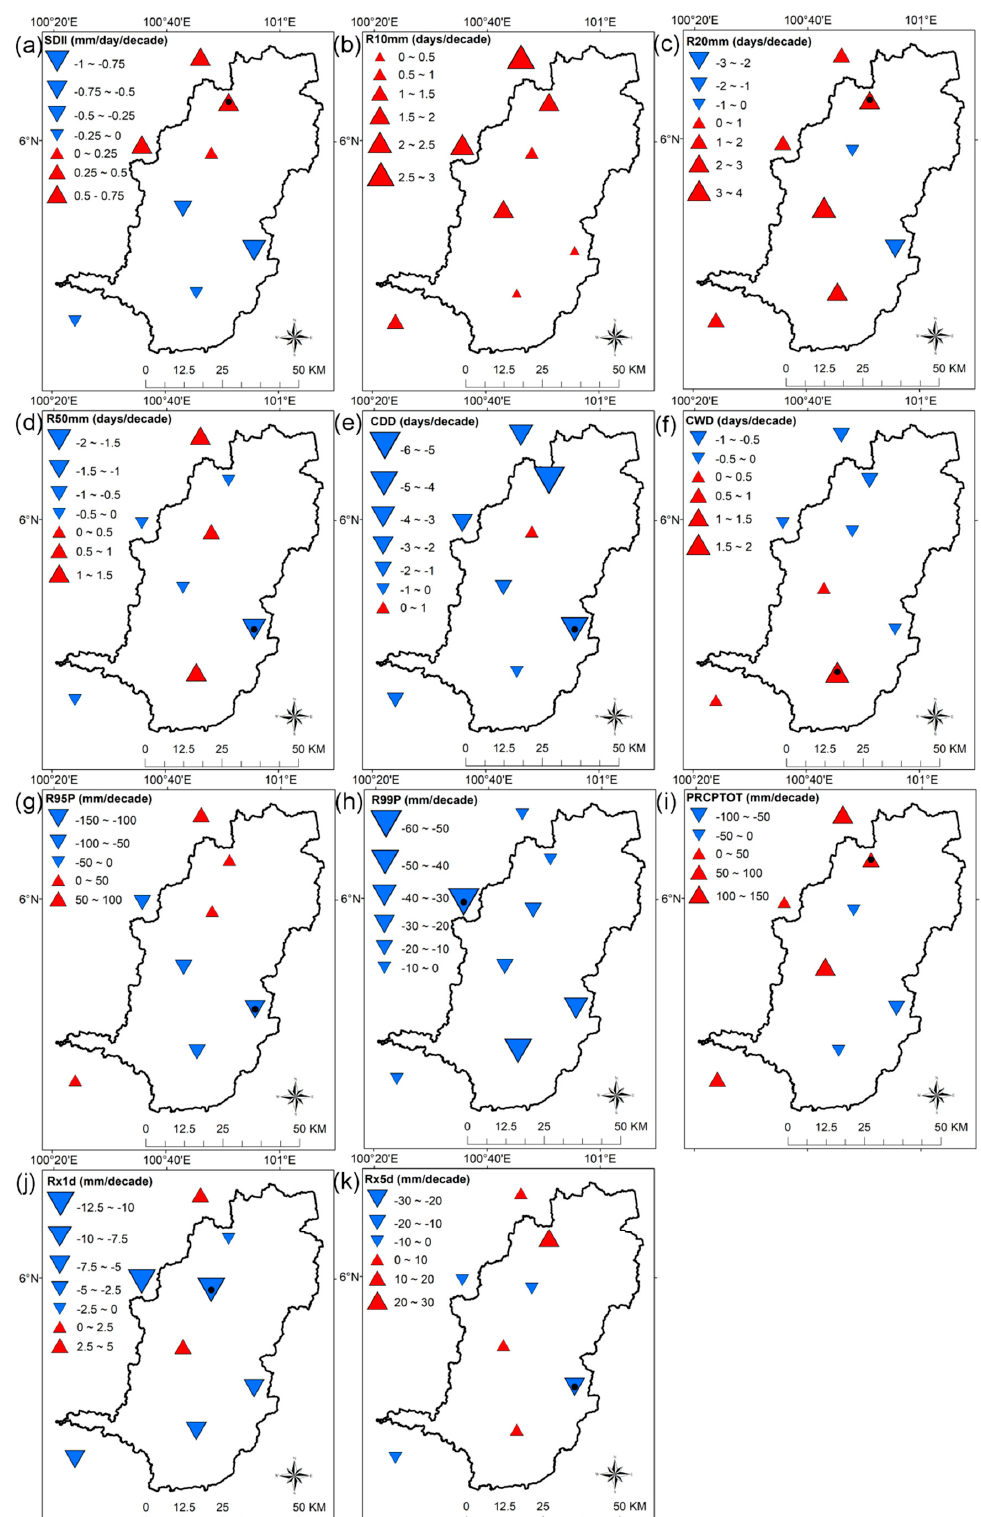
Figure 5. Spatial distribution of precipitation extremes trends and magnitude over the Muda River Basin from 1985 to 2015. Black dots indicate significant trend at a 95% significance level. ( a ) SDII; ( b ) R10mm; ( c ) R20mm; ( d ) R50mm; ( e ) CDD; ( f ) CWD; ( g ) R95p; ( h ) R99p; ( i ) PRCPTOT; ( j ) Rx1d; ( k )